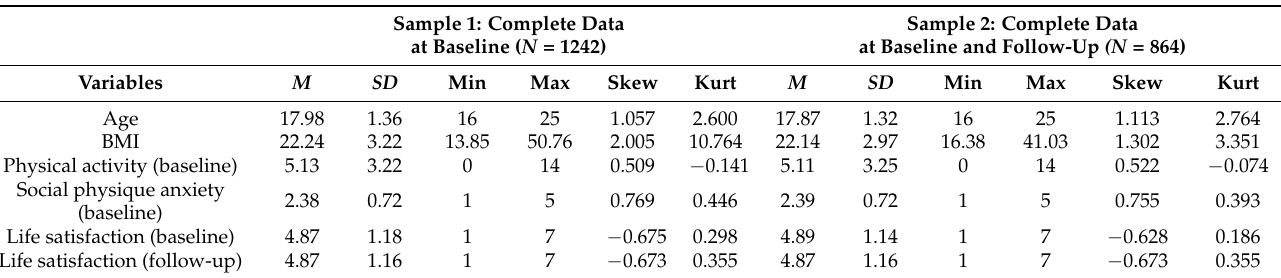
Table 1. Descriptive statistics of the main study variables.